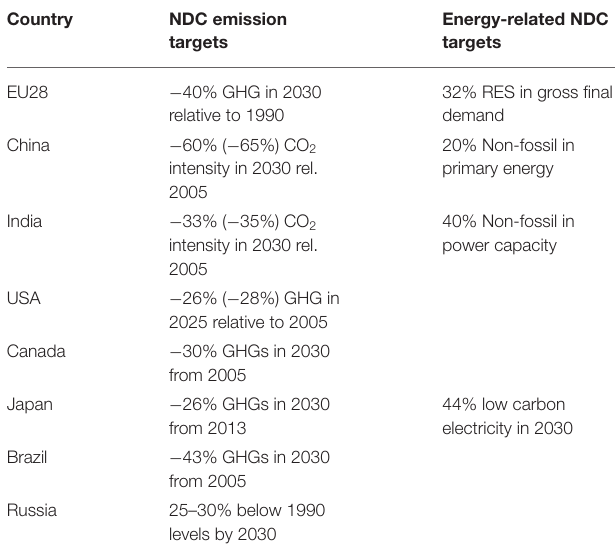
TABLE 2 | NDC emission targets included in the Reference scenario (submitted until 2020).